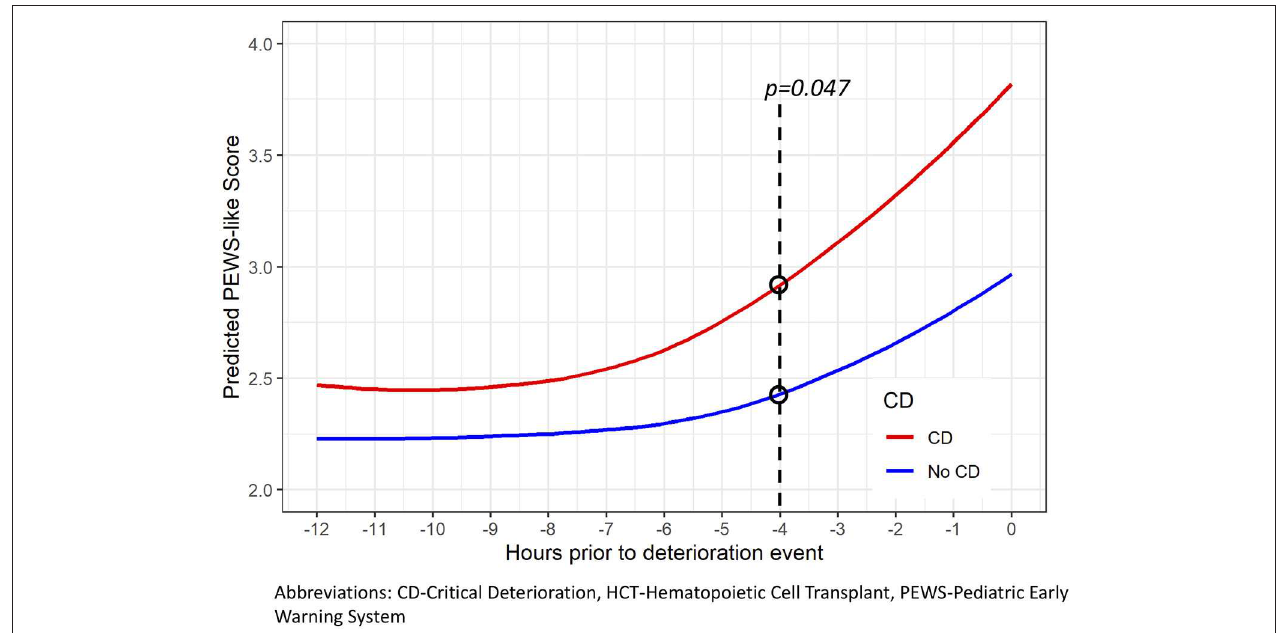
FIGURE 2 | The predicted PEWS-Like-Score (PEWS-LS) over time prior to deterioration event in hospitalized pediatric hematology-oncology patients. Trends in PEWS-LS prior to PICU admission were analyzed using a generalized estimating equation (GEE) Poisson model implemented in the GLIMMIX procedure of SAS (empirical option) with time as a restricted cubic spline with 4 knots ( − 11.5, − 7.75, − 4.25, and − 0.5h), CD as binary variables, and the two-way interaction of time and CD as predictors. Both time ( p < 0.001) and CD ( p < 0.001) were significant predictors of PEWS-LS, but the two-way interaction was not significant ( p = 0.26). At time of PICU transfer or intervention, the predicted mean PEWS-LS was 2.95 (95% CI 2.63, 3.31) for events without CD, and 3.81 (3.53, 4.11) for events with CD. Thus, the predicted PEWS-LS was 0.86 points higher in events with CD at the start of the event, p = 0.0003.